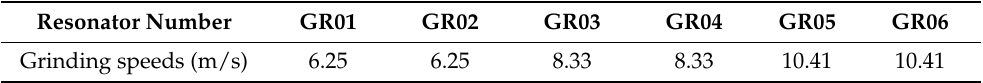
Table 1. Grinding speeds of resonators.